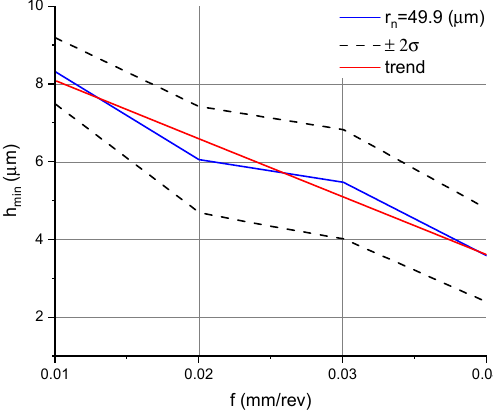
Figure 5. Minimum chip thickness vs. feed for the DCMT 11 T3 08–PF 4325 insert with a 49.9 µm edge radius.